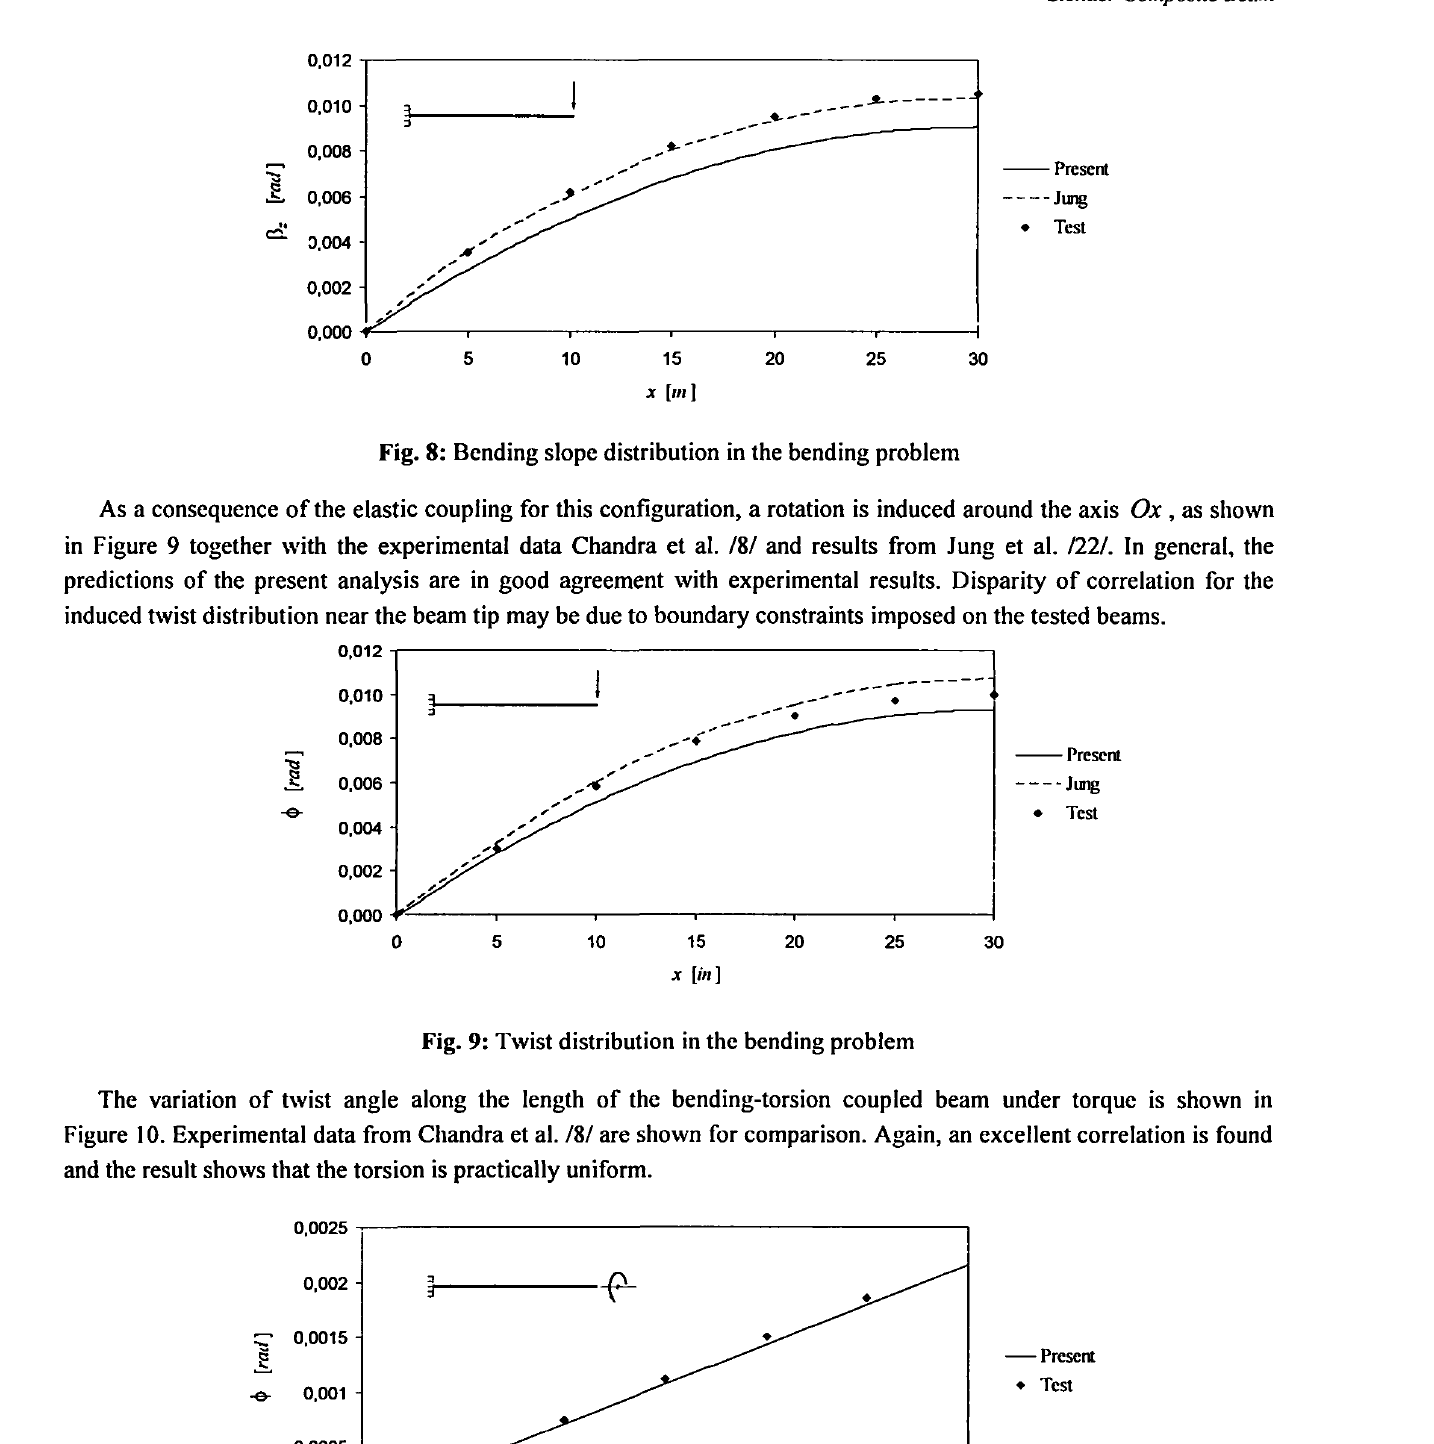
Fig. 10: Twist distribution in the torsion